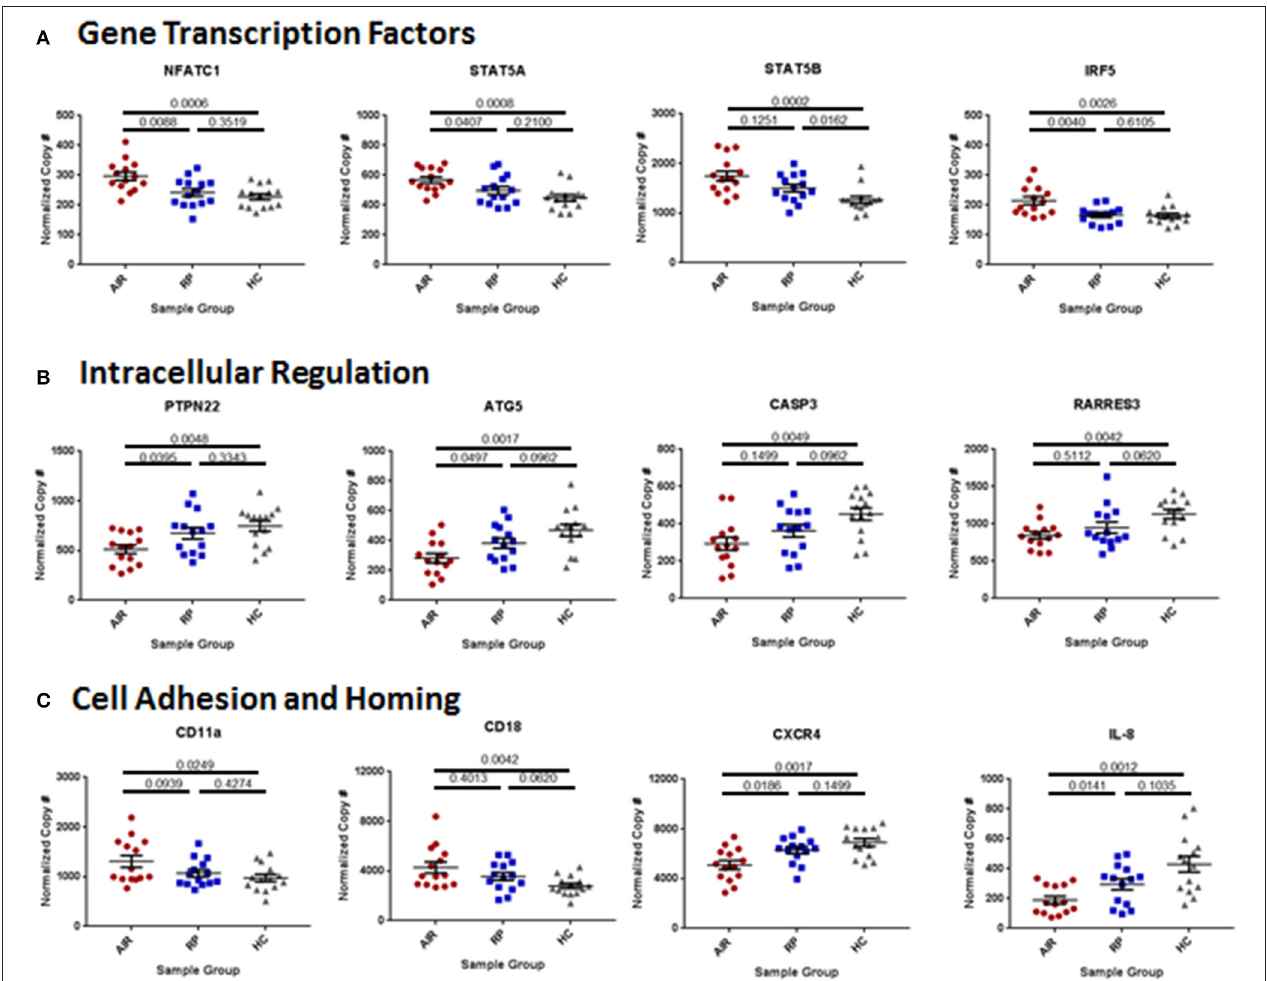
FIGURE 5 | Differences in immune mediator gene expression between AIR patients and control groups. Total RNA was isolated from 2.5mL of whole blood collected in PAXgene tubes from 14 individuals in each group. Quality of RNA was confirmed in house prior to sending the sample for analysis of mRNA copy numbers using the NanoString Human Immunology Panel. Statistical analysis was performed on the top 445 expressed genes of the 579 immune-associated genes on the panel, of which 53 were very differentially expressed between AIR patients and healthy controls (adjusted P -value < 0.025). The graphs show normalized and batch-corrected mRNA copy numbers for twelve of the most different genes with each dot representing a different patient. (A) Expression of the transcription factors: nuclear factor of activated T cells 1, signal transducer and activator of transcription 5A and 5B, and interferon response factor 5. (B) Expression of regulators of cell activation: protein tyrosine phosphatase non-receptor type 22, autophagy related 5, caspase 3, and retinoic acid receptor responder 3. (C) Expression of the two subunits (CD11a and CD18) of the cell adhesion molecule: lymphocyte function-associated antigen 1 (LFA-1); expression of CXCR4, the receptor for the chemokine stromal cell-derived factor-1 (SDF-1, CXCL12); and expression of the chemokine interleukin-8 (CXCL8) that is an attractant for neutrophils to sites of infection or